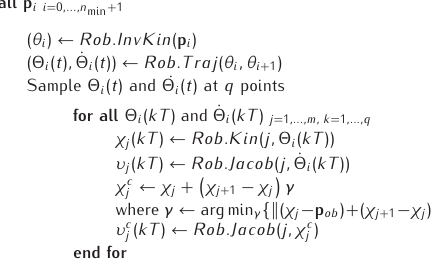
Figure 5. Comparison of the path (dotted line) (a) without ( f V considering the obstacle relative